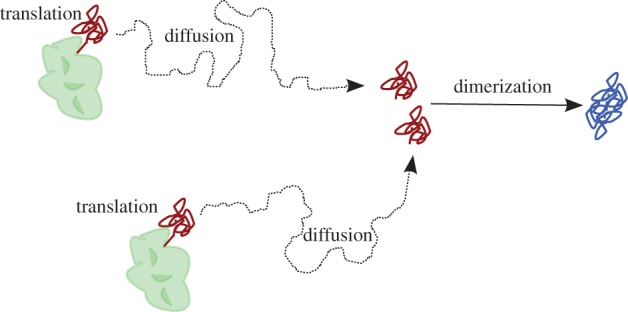
Schematic diagram of protein dimerization model (4.1). Uniformly distributed ribosomes (green) translate proteins (red). These diffuse in the cytosol until a pair combines to form a dimer (blue).